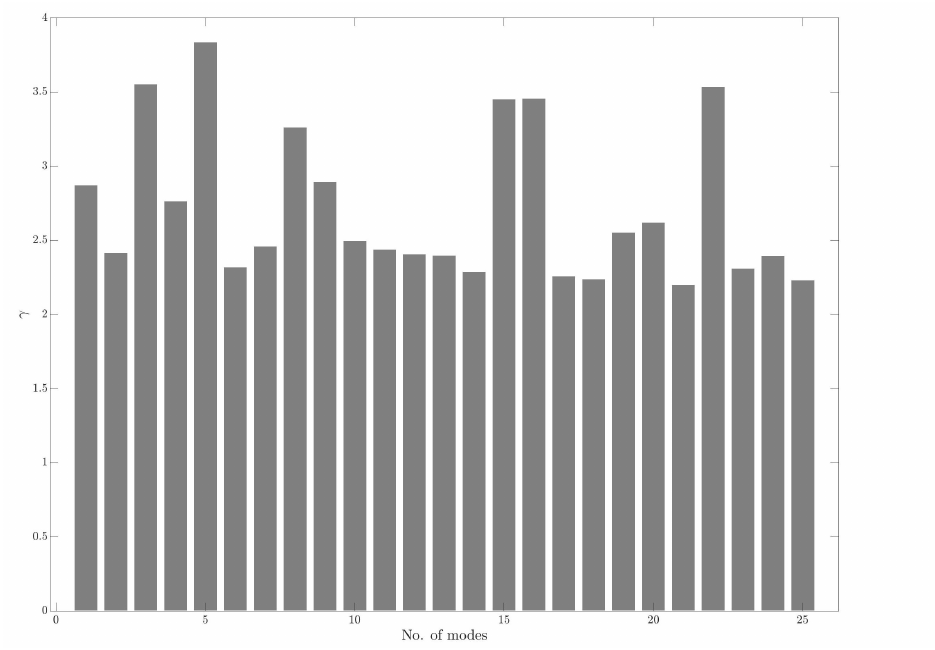
Figure 5. Optimum values of the kernel parameter for each vibration mode. As expected, the method results in a large intraclass distance between features to identify classes with very similar values in the dataset, i.e., a small interclass distance.